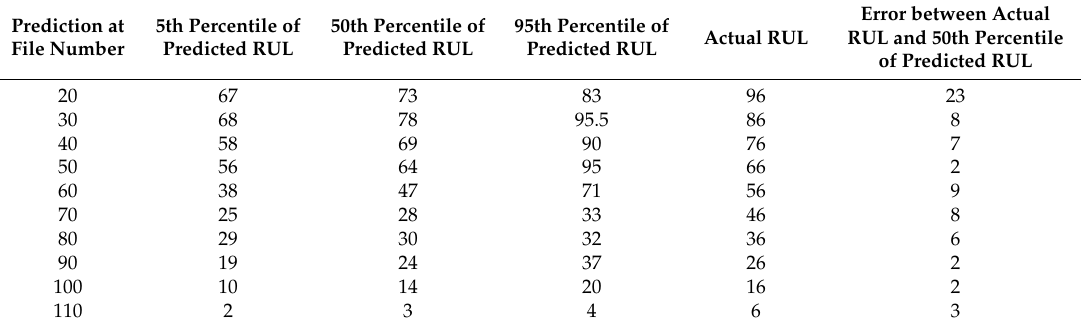
The predictions of the RUL by the proposed bearing prognostic method (Unit: measurement number).